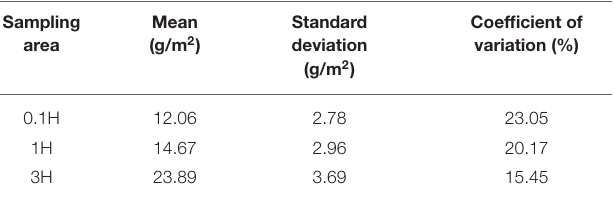
TABLE 2 | Statistical analysis of normalized water productivity (WP) of cotton plants at different areas (0.1H, 1H, and 3H). Sampling